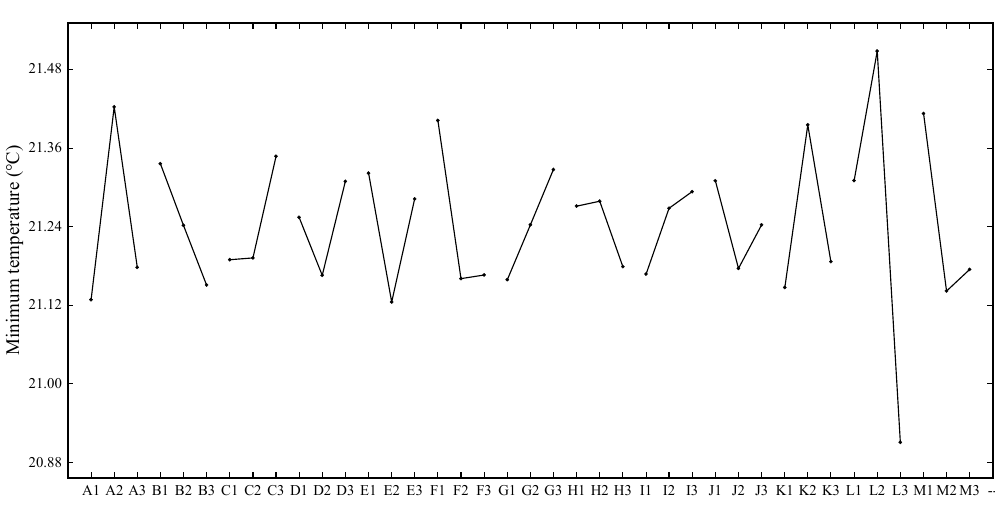
Figure 7. Maximum temperature effect curve.